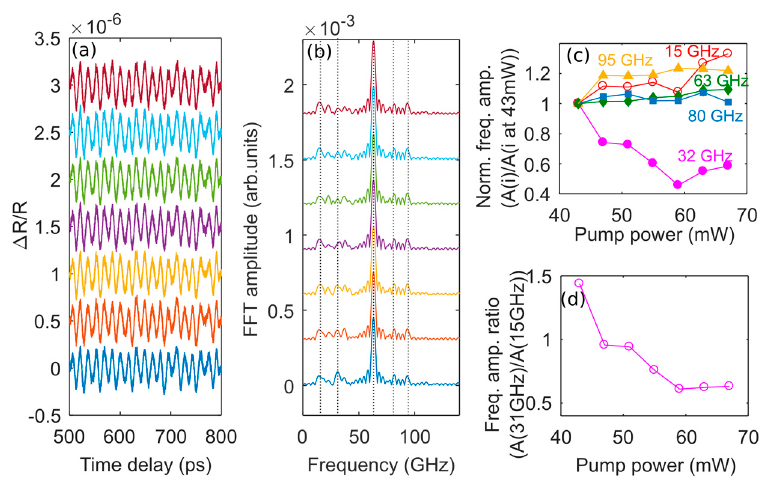
Figure 7. ( a ) Coherent acoustic phonon and ( b ) spectrum in the time interval from 500 ps to 800 ps at the pump power from 43 mW (bottom) to 67 mW (top) in steps of 4 mW. ( c ) Normalized frequency amplitude to the amplitude at lowest pump power for each frequency. ( d ) Frequency amplitude ratio between 32 GHz center mode and 15 GHz edge mode.